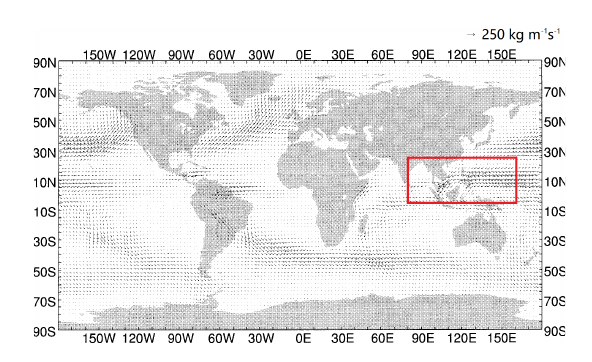
FIGURE 1 The moisture fl uxes within ARs (kg m − 1 s − 1 ) averaged during January 1992, 1995, and 1996 using data from the European Centre for Medium-Range Weather Forecasts (taken from Zhu and Newell (1998) © American Meteorological Society. Used with permission). The red box shows the study region of this